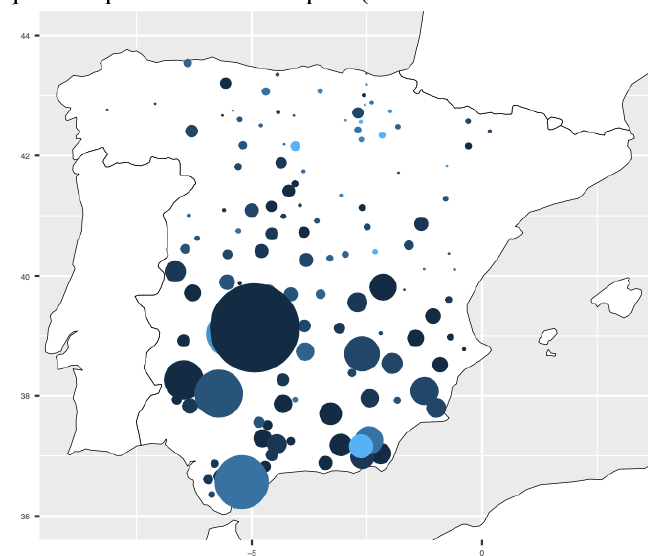
Figure 2. Geographical spread of ‘namasque’ (Locations with >5 tokens